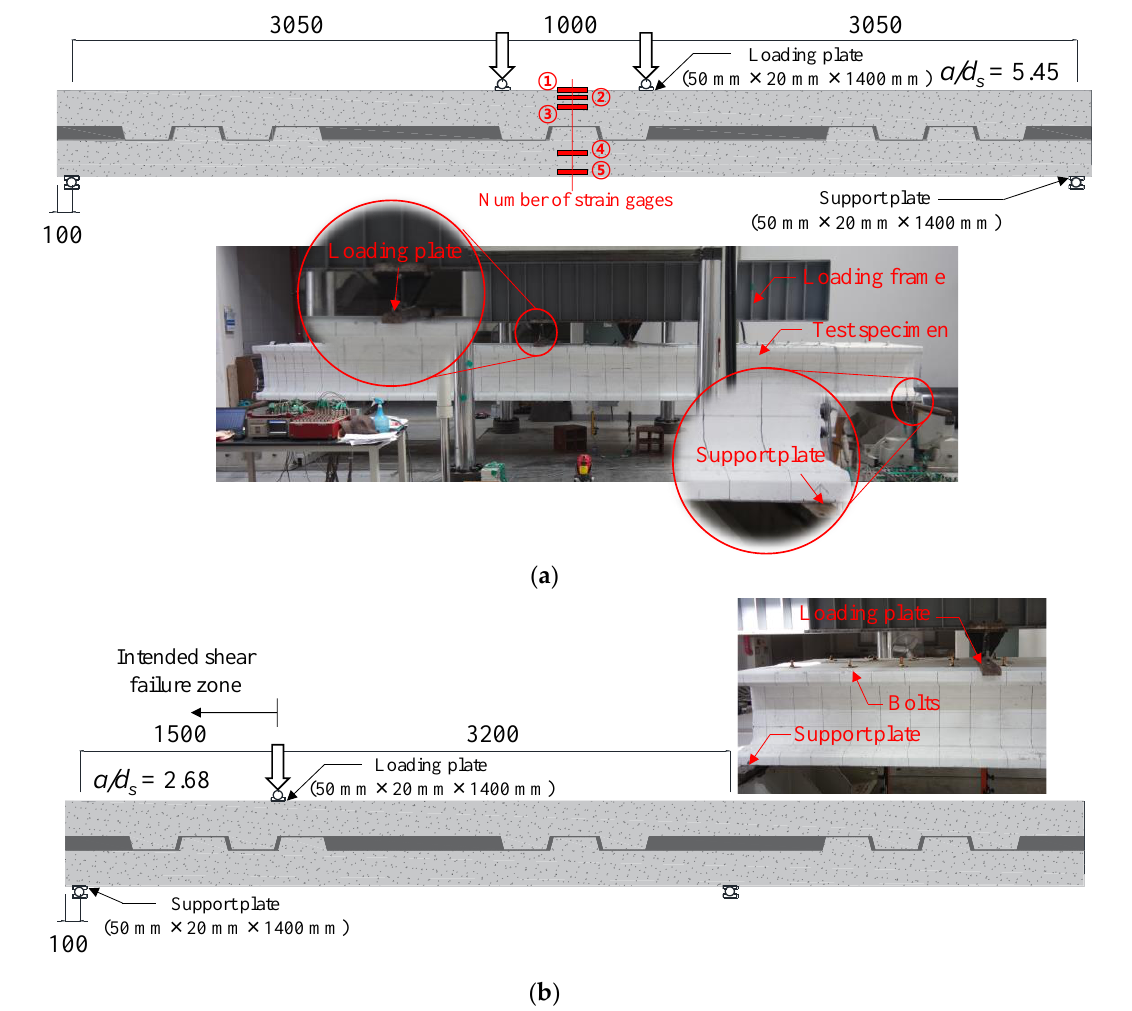
Figure 5. Loading details (unit: mm): ( a ) DCW-F specimen; ( b ) DCW-S specimen series.